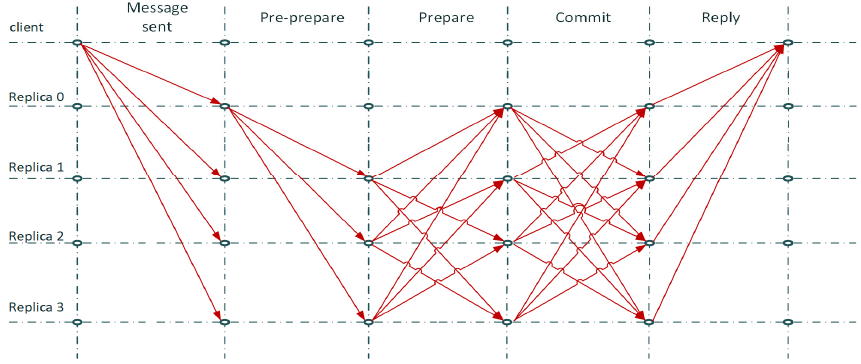
Figure 2. PBFT diagram.